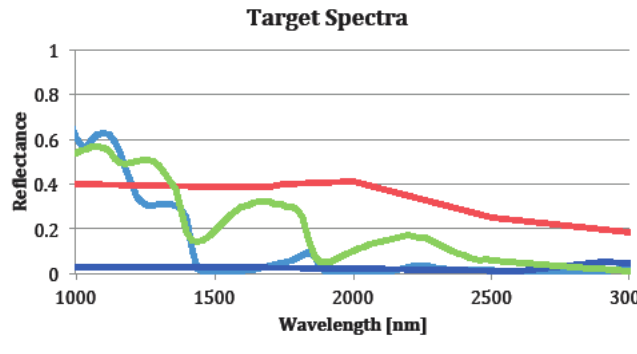
Figure 15. Spectral reflectance of the four surface targets used in the out-of-band response analysis. The spectra originate from MODTRAN’s spectral library